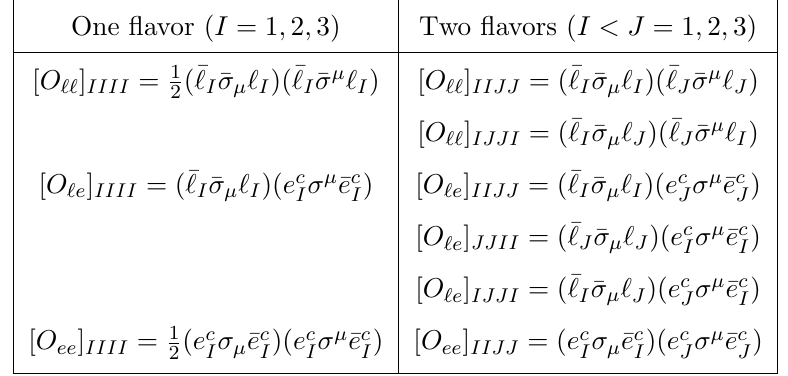
Table 2 . Flavor-conserving 4-lepton operators in the SMEFT Lagrangian of eq.